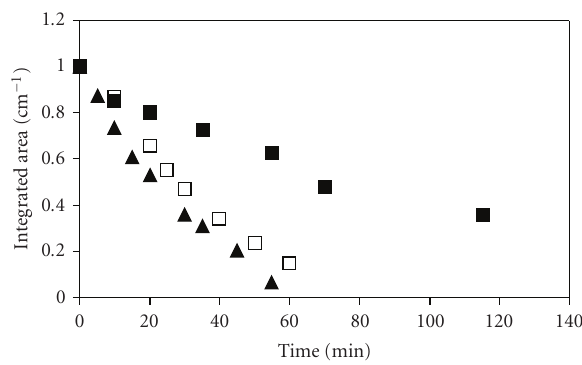
Figure 7: Photoactivity for the degradation of stearic acid (nor- malised) for (cid:4) Ag(2), (cid:3) TiO 2 on Ag(2), (cid:2) TiO 2 on Ag repeat.